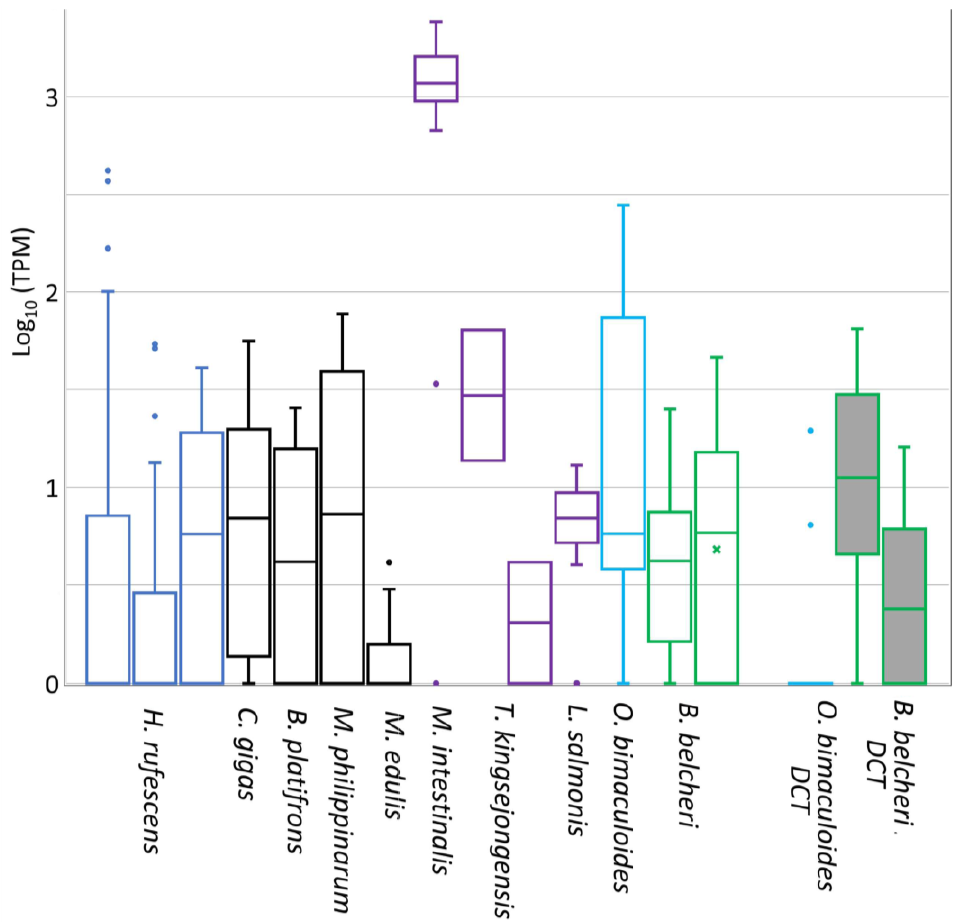
Figure 5. Box plot of the expression values of DCE/ yellow genes in non-insect metazoans. Expression values are reported as log transformed Transcript Per Million (TPM) for the gastropod H. rufescens (3 genes, 40 samples); for the bivalves C. gigas (165 samples), B. platifrons (6 samples), M. philippinarum (5 samples), M edulis (41 samples); the copepods M. intestinalis (20 samples), T. kingsejongensis (2 genes, 2 samples), L. salmonis (50 samples); the cephalopod O. bimaculoides (19 samples) and the lancelet